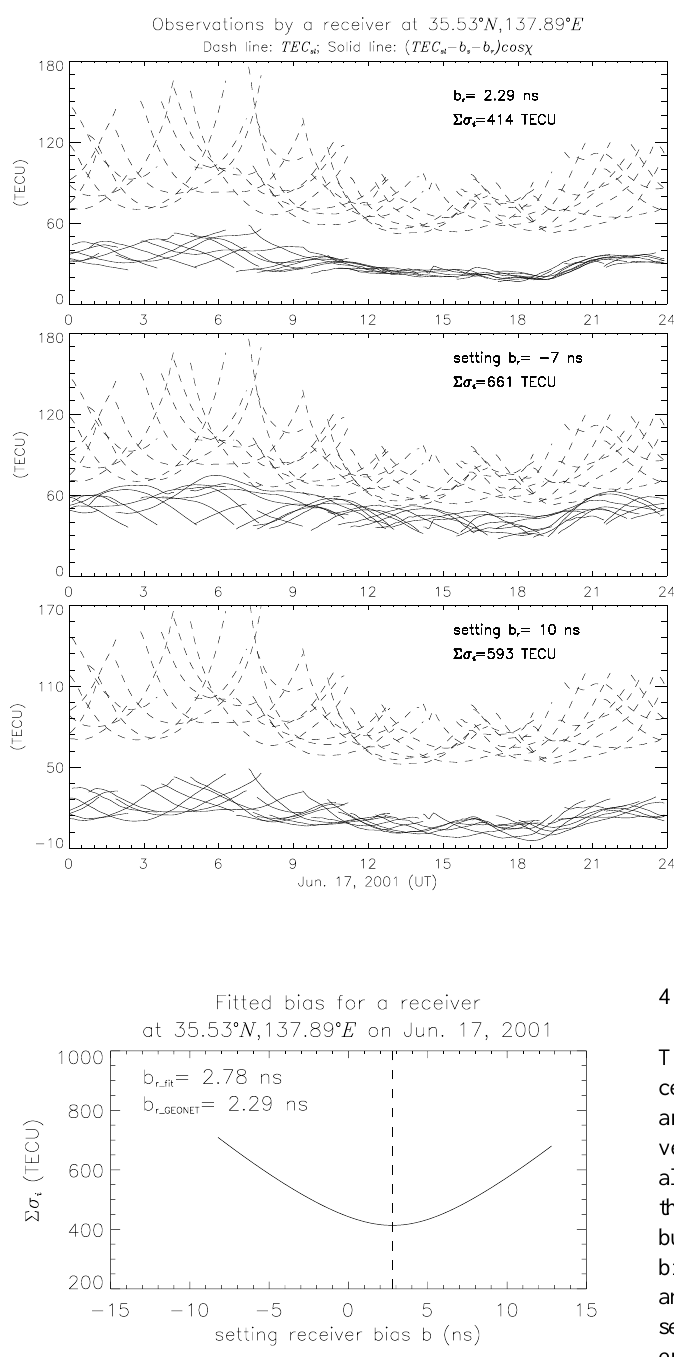
Fig. 10. Fitted bias to a receiver at 35.53 ◦ N, 137.89 ◦ E. The GEONET derived bias value, 2.29ns, is also